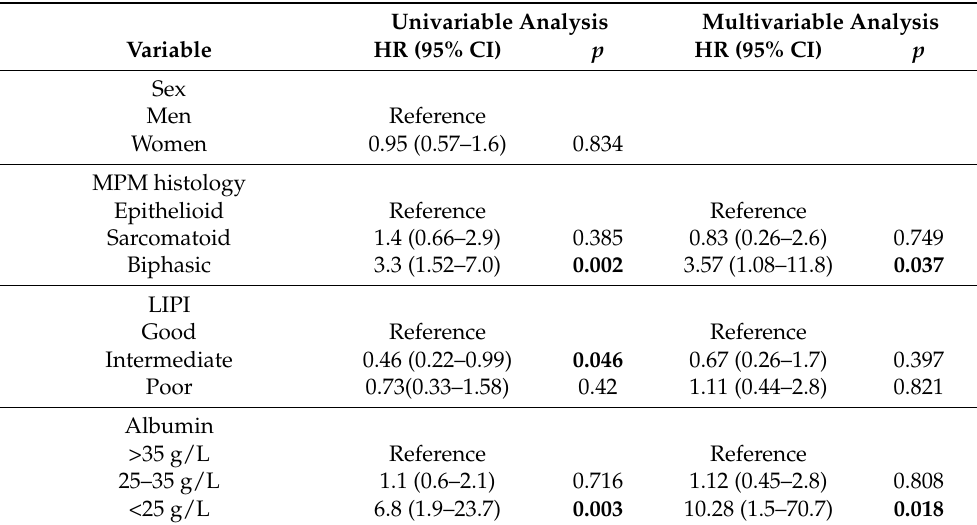
Figure 1. Kaplan–Meier estimated probabilities of ( A ) PFS and ( B ) OS for the entire cohort. Table 2. Univariable and multivariable Cox regression model results for overall